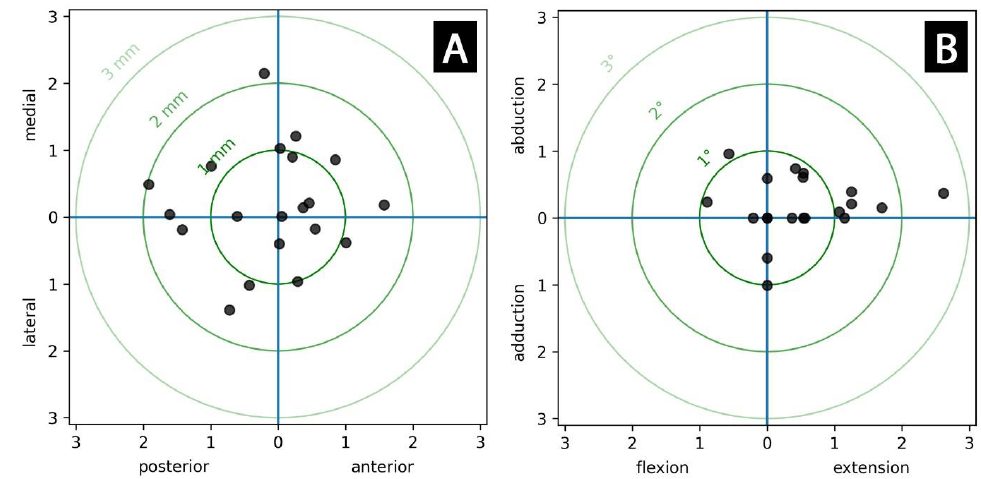
Figure 3. Scatter plots for deviation of ( A ) the axis (offset) (mm) and ( B ) the axis alignment (°) of the final fixture position compared to the preoperative plan.